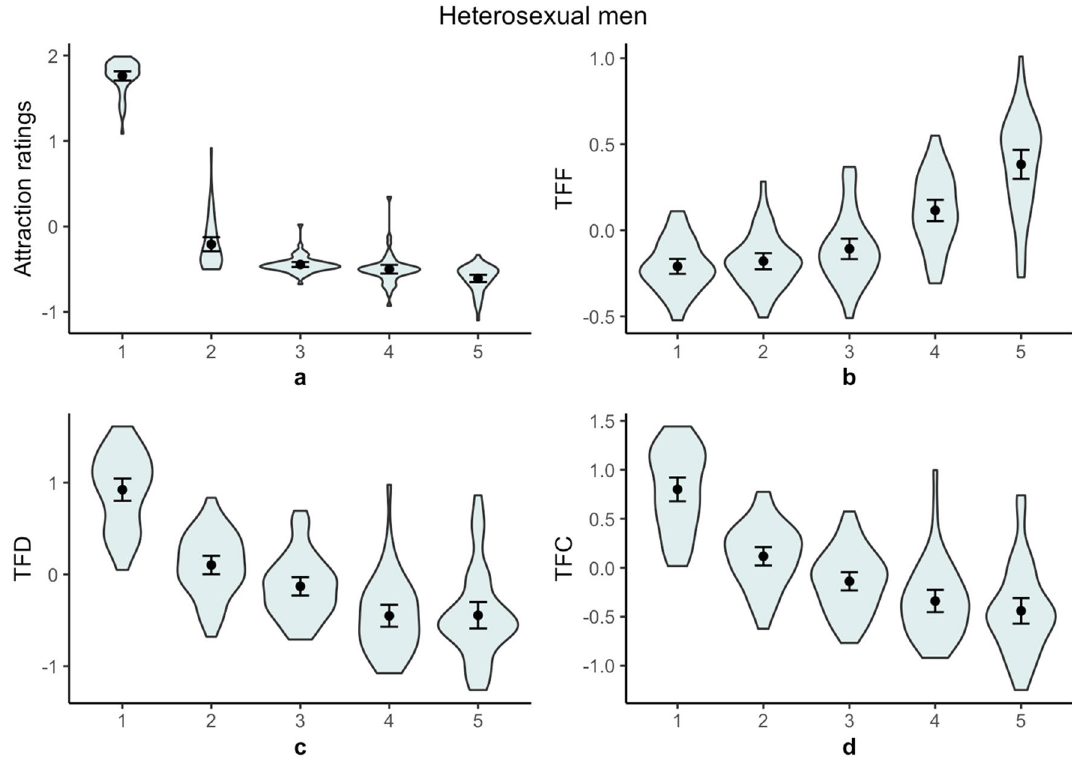
Figure 1. Heterosexual men’s ( a ) standardized attraction ratings, ( b ) standardized time to first fixation (TFF), ( c ) standardized total fixation duration (TFD), and ( d ) standardized total fixation count (TFC) by stimuli category. 1 = cisgender women, 2 = feminine trans individuals with breasts, 3 = feminine trans individuals without breasts, 4 = cisgender men, 5 = bonobos. Points indicate mean values. Capped lines show 95% confidence intervals. Shapes show the density of data